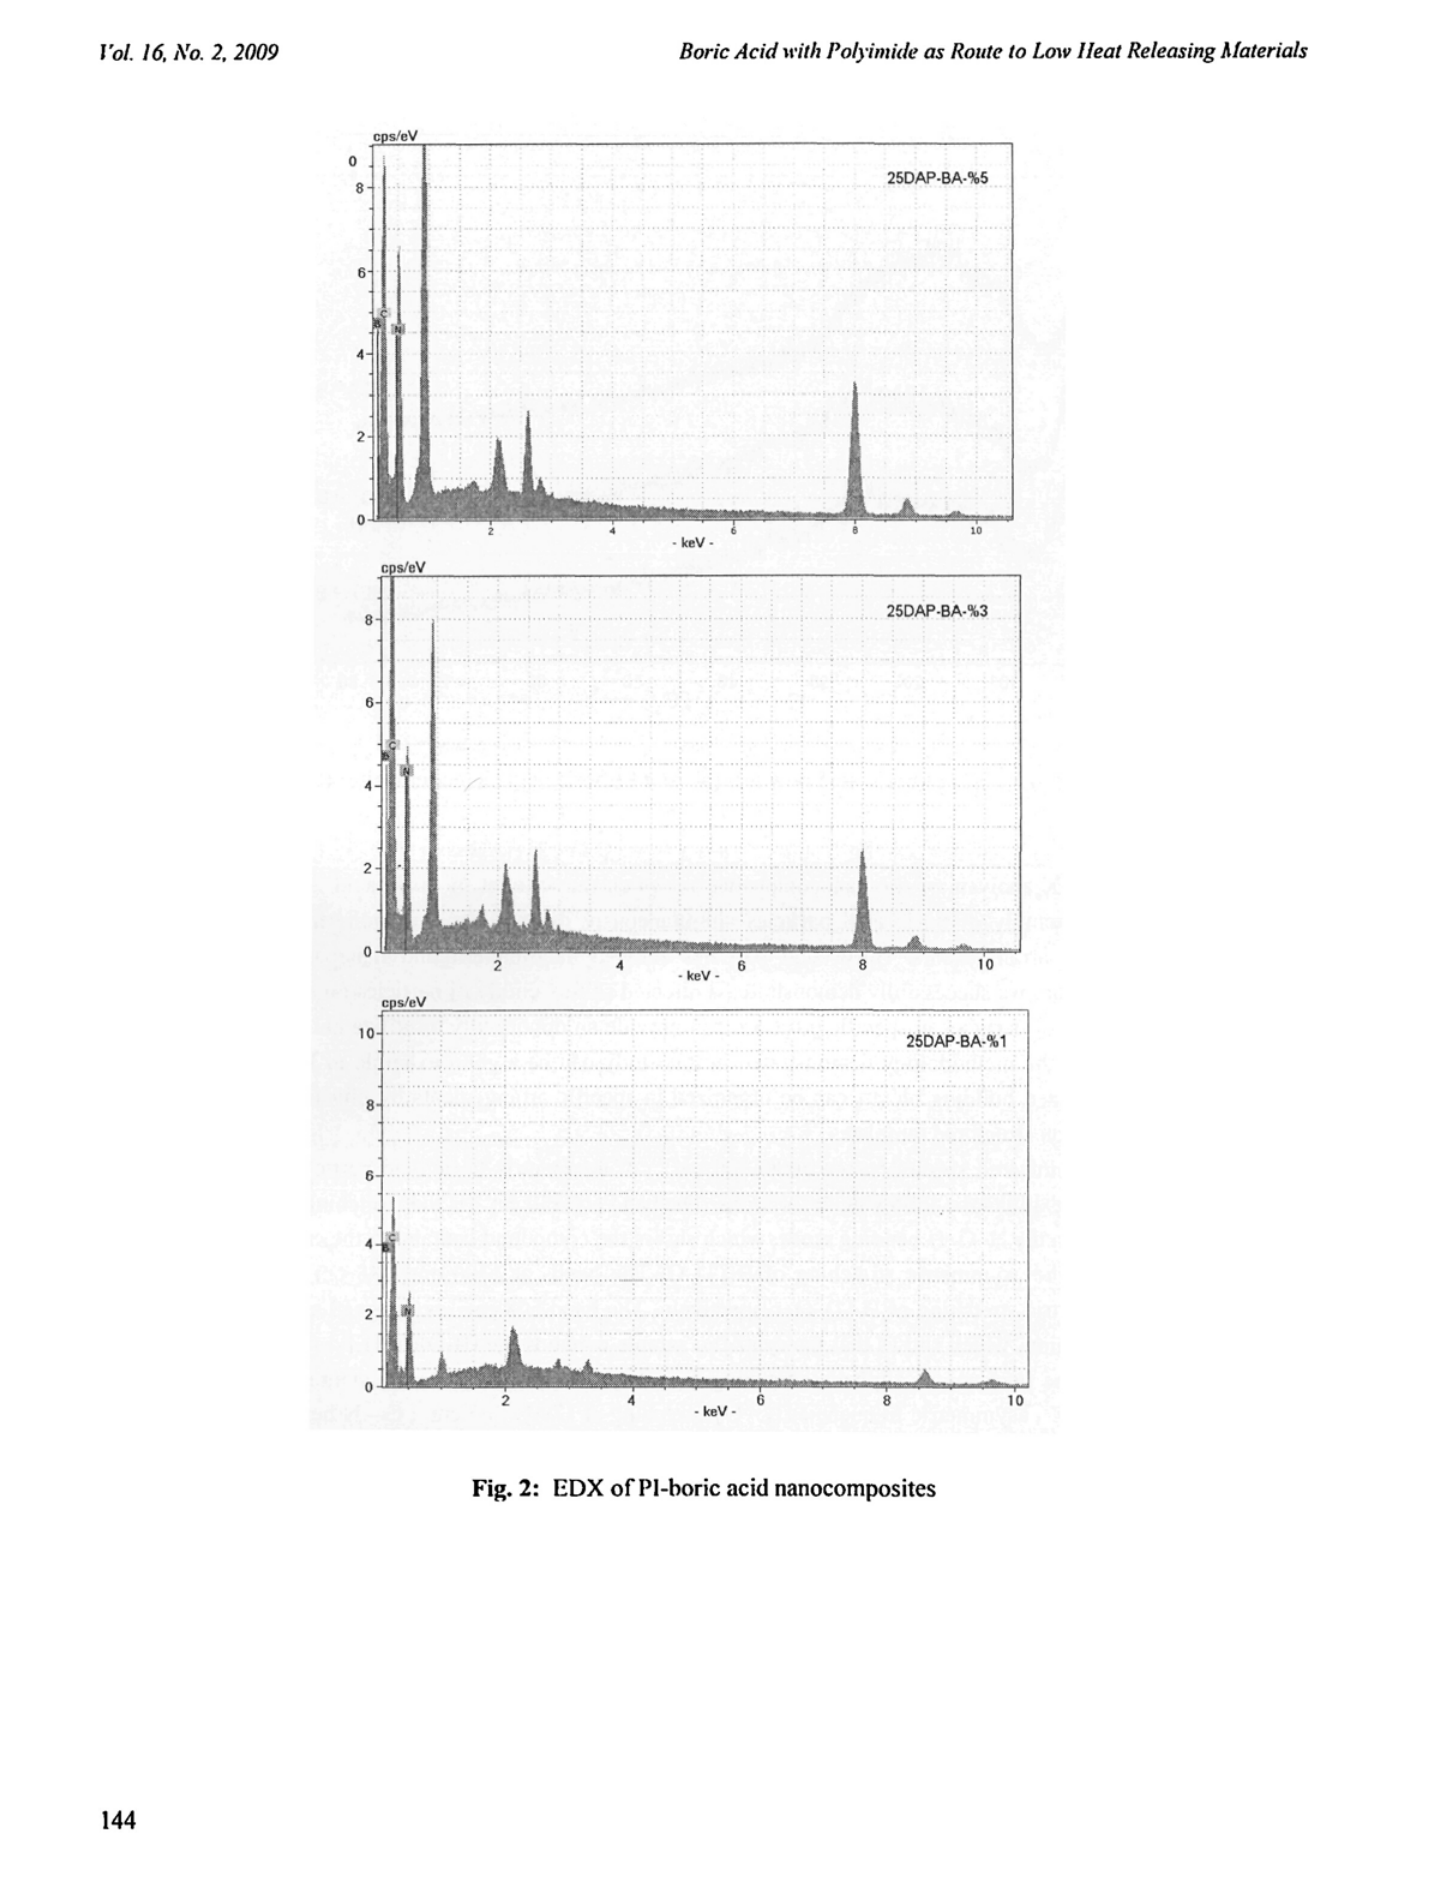
Fig. 2: EDX of Pi-boric acid